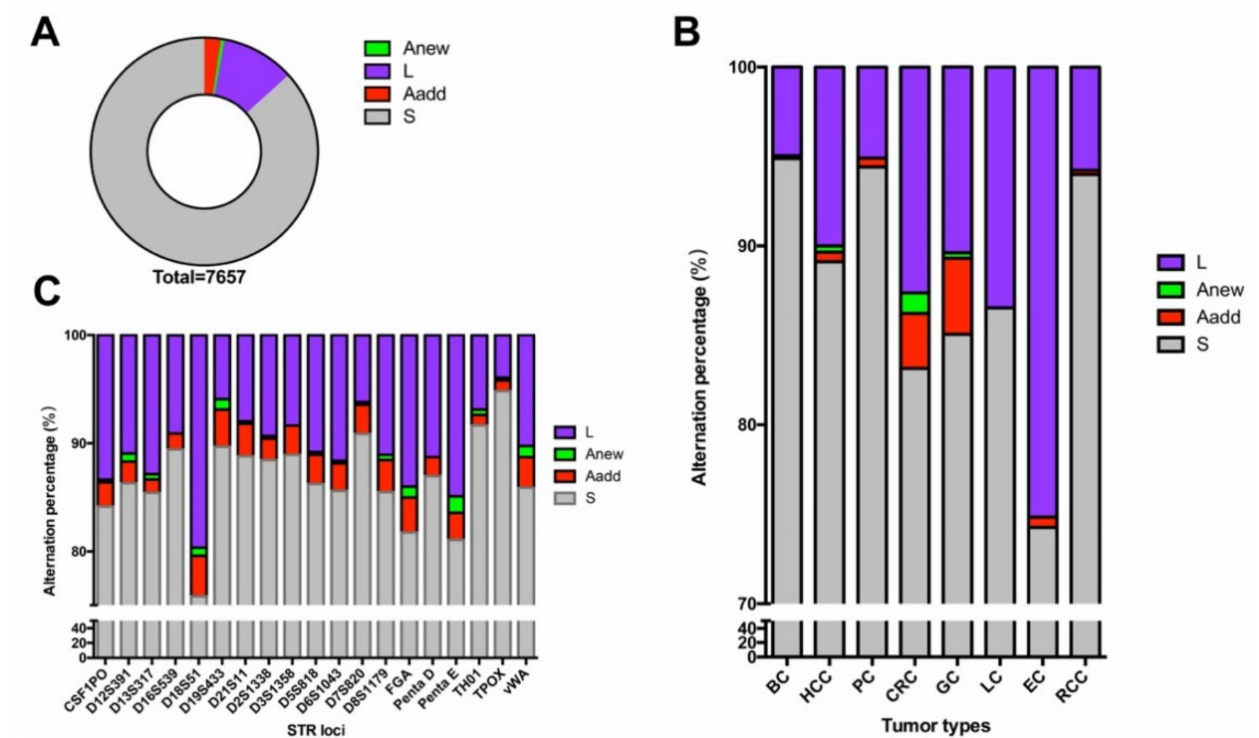
Figure 2. STR alterations across the paired tumors: ( A ) Distribution of the genetic instabilities in STR mutations, ( B ) fre- quency of genetic status at each of the tumor type, ( C ) percentage of genetic status at each of the STR locus. Occurrence of a new allele (Anew), loss the heterozygosity (L), occurrence of an additional allele (Aadd), stable